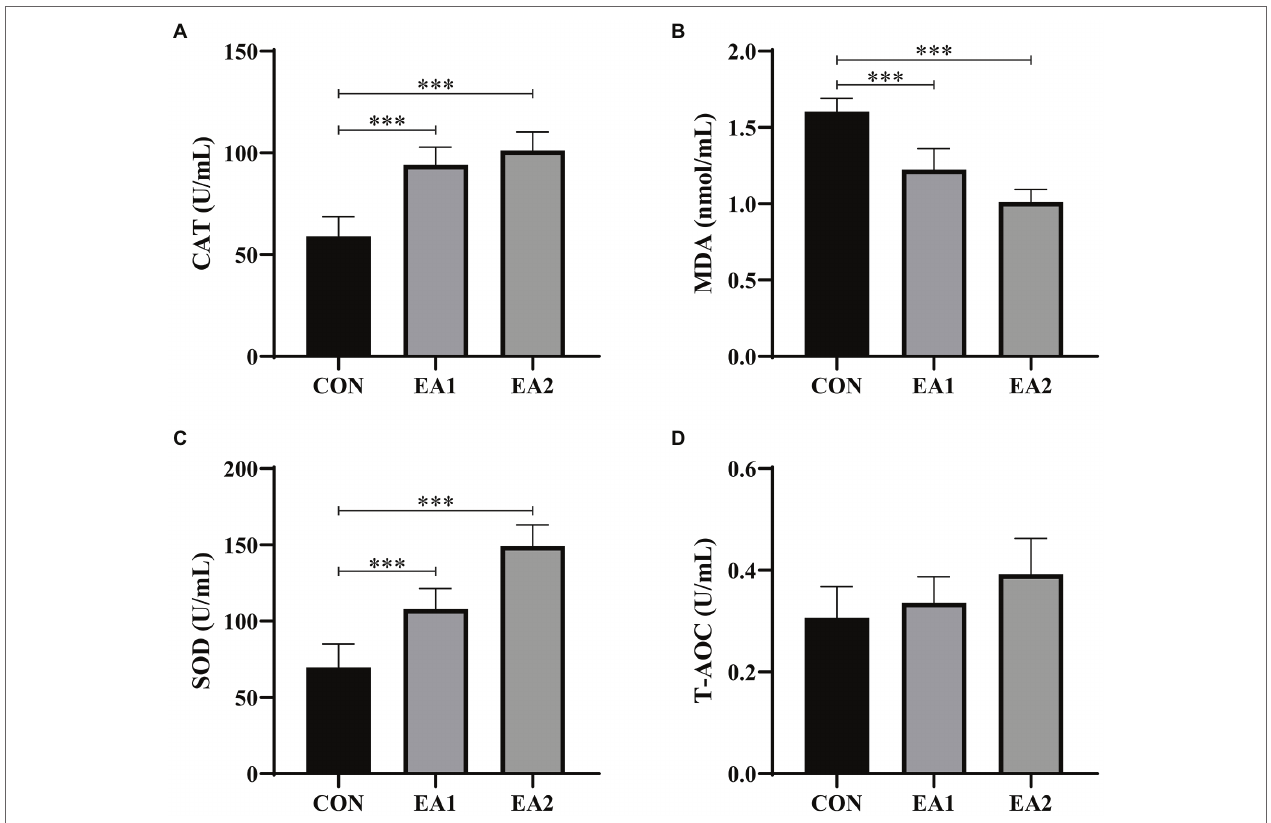
FIGURE 5 | Effects of EA supplementation on antioxidant activities in liver. The contents of hepatic catalase (CAT) (A) , malonaldehyde (MDA) (B) , superoxide dismutase (SOD) (C) , and total antioxidant capacity (T-AOC) (D) were determined by the ELISA kits. The values are reported as the mean ± SD of 12 mice per group: *** p < 0.001 represents significant differences compared with the control